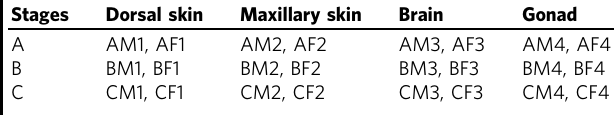
Table 2 Sampling codes for transcriptomic